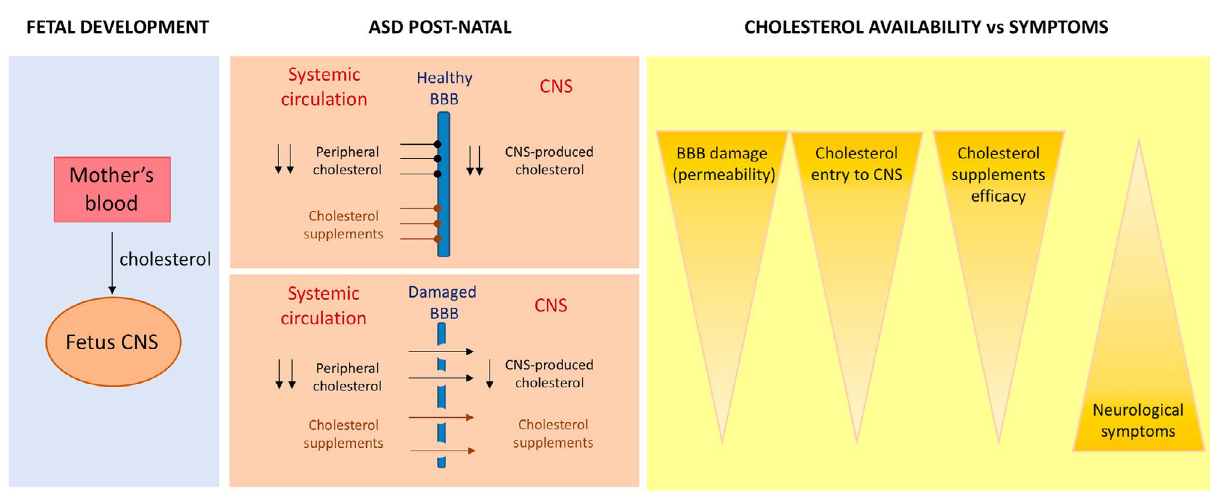
Figure 1. Flux of cholesterol in ASD coursing with cholesterol dyshomeostasis. During pregnancy (left), cholesterol from the mother reaches all organs in the fetus. After birth, cholesterol from the periphery of from supplements do not enter in the central nervous system (CNS) in the case of well-formed BBB but it could enter in a damaged BBB (center). In the latter case, the cholesterol from the supplements can enter the patient’s CNS and improve neurological symptoms, since the features of ASD would depend on the availability of cholesterol